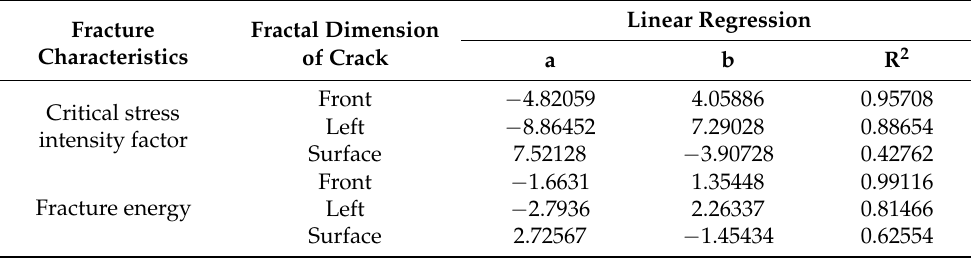
Linear Regression